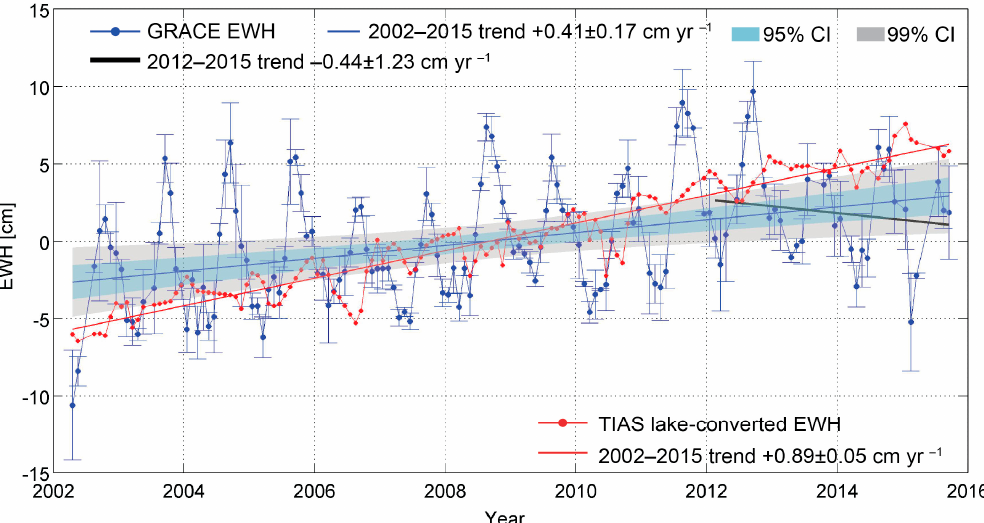
Figure 6. TIAS water mass anomaly compared with GRACE data centered at the study site.